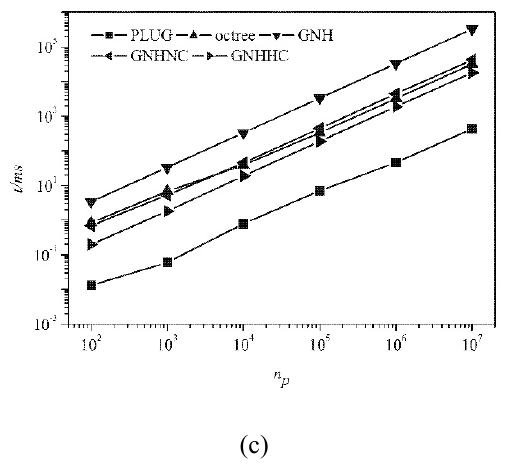
Figure 12. Scalability of the different methods with regard to the increasing number of the particles on the different types of meshes. ( a )Hexahedral mesh; ( b ) Tetrahedral mesh; ( c ) Polyhedral mesh.